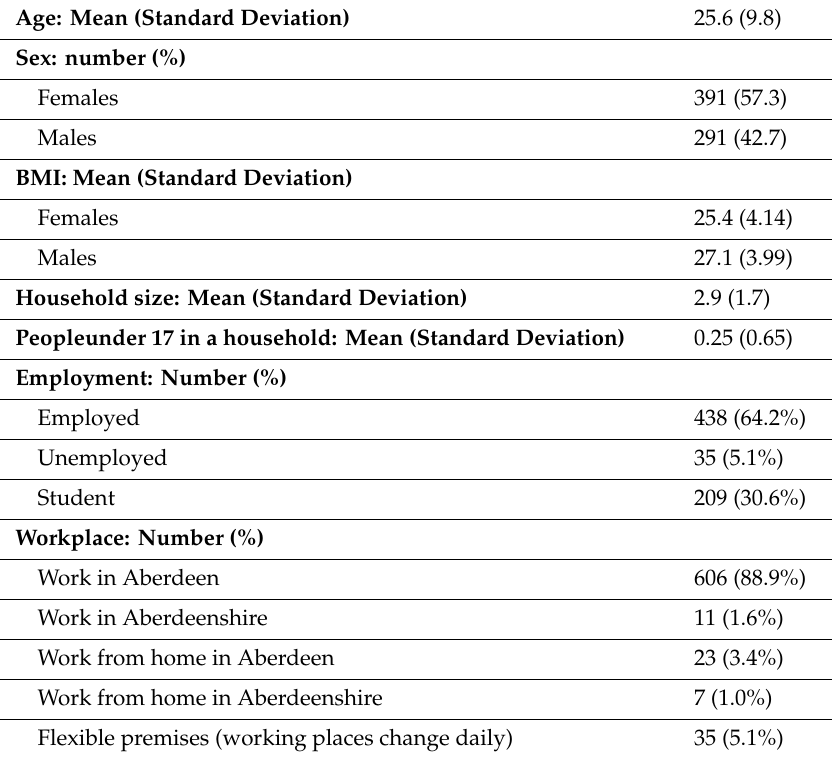
Table 1. Descriptive statistics: sociodemographic characteristics of the study